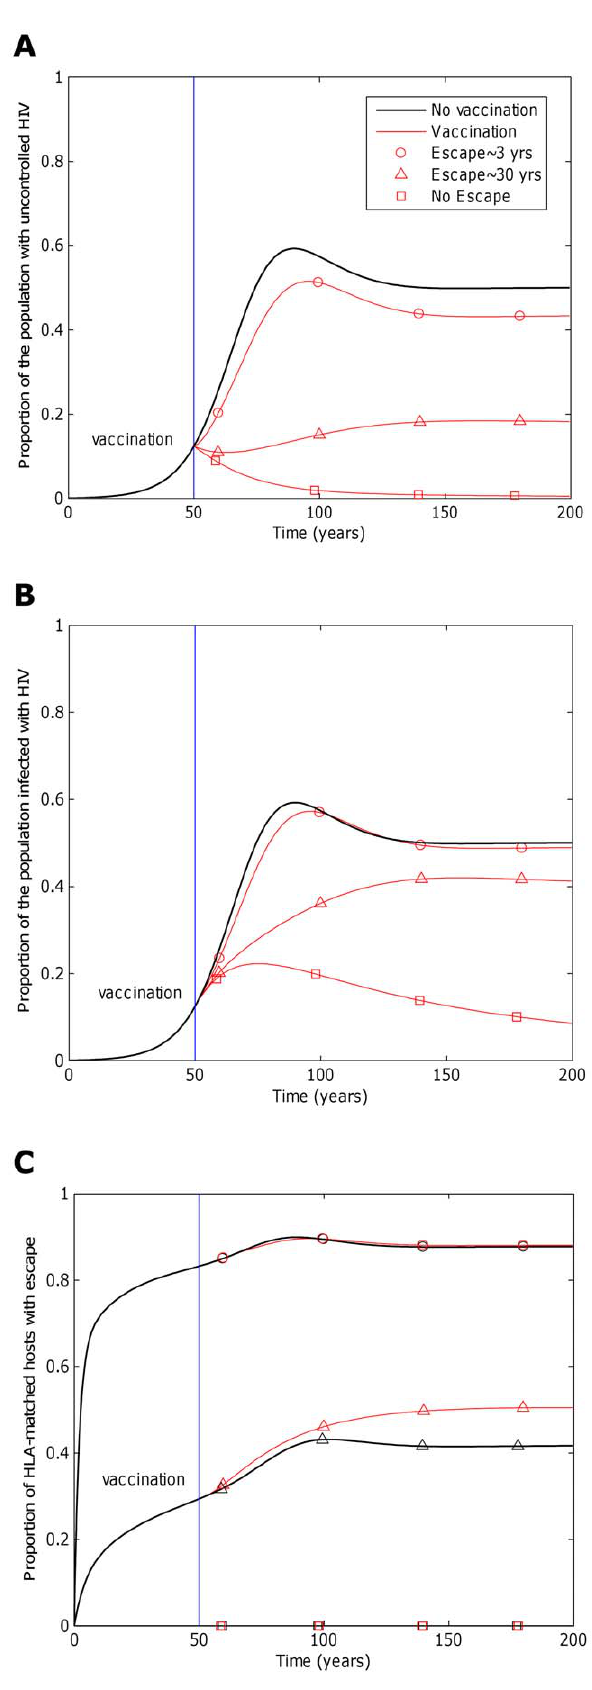
Figure 3. The impact of a vaccine will be greater if the rate at which immune escape mutants emerge is slower. This figure explores how the rate at which immune escape mutants emerge in HLA matched hosts affects the impact of a five-epitope vaccine delivered to the all hosts in the population ( c ~ 1 ) 50 years into an epidemic. Three different escape rates are considered: rapid escape (circles w i ~ ~ ww i ~ 1 = 3 years 2 1 for i =1:5), slow escape (triangles; w i ~ ~ ww i ~ 1 = 30 years 2 1 for i =1:5) and no escape (squares; w i ~ ~ ww i ~ 0 years 2 1 for i =1:5) at each epitope. In each example, escape occurs at the same rate in vaccinated and unvaccinated hosts ( w i ~ ~ ww i for i =1:5). Reversion takes an average of 36 years at each epitope in both vaccinated an unvaccinated hosts ( y i ~ 1 = 36 years 2 1 for i =1:5). A) shows the proportion of hosts with uncontrolled HIV. B) shows the proportion of hosts infected with HIV. C) shows the escape prevalence amongst HLA-matched hosts. The impact of vaccination (red lines) is compared to the scenario where vaccination is absent (black lines). This figure shows that the prevalence of escape amongst HLA-matched hosts at each epitope would be lower (C) and the vaccine would be more effective in reducing the prevalence of uncontrolled HIV (A) and HIV infection (B) if the rate of escape were slower. The assumptions and parameters used in these figures are the same as those described for Figure 2 except that the infectiousness and life expectancy of successfully vaccinated hosts are fixed at ~ bb c ~ 0 : 008 and m z ~ aa ~ 1 = 50 , respectively ( L vac ~ 0 : 4 ). Note that in this figure and the remaining figures, different markers (e.g. circles, triangles and squares) are used to distinguish between different model outputs. These do not represent data.